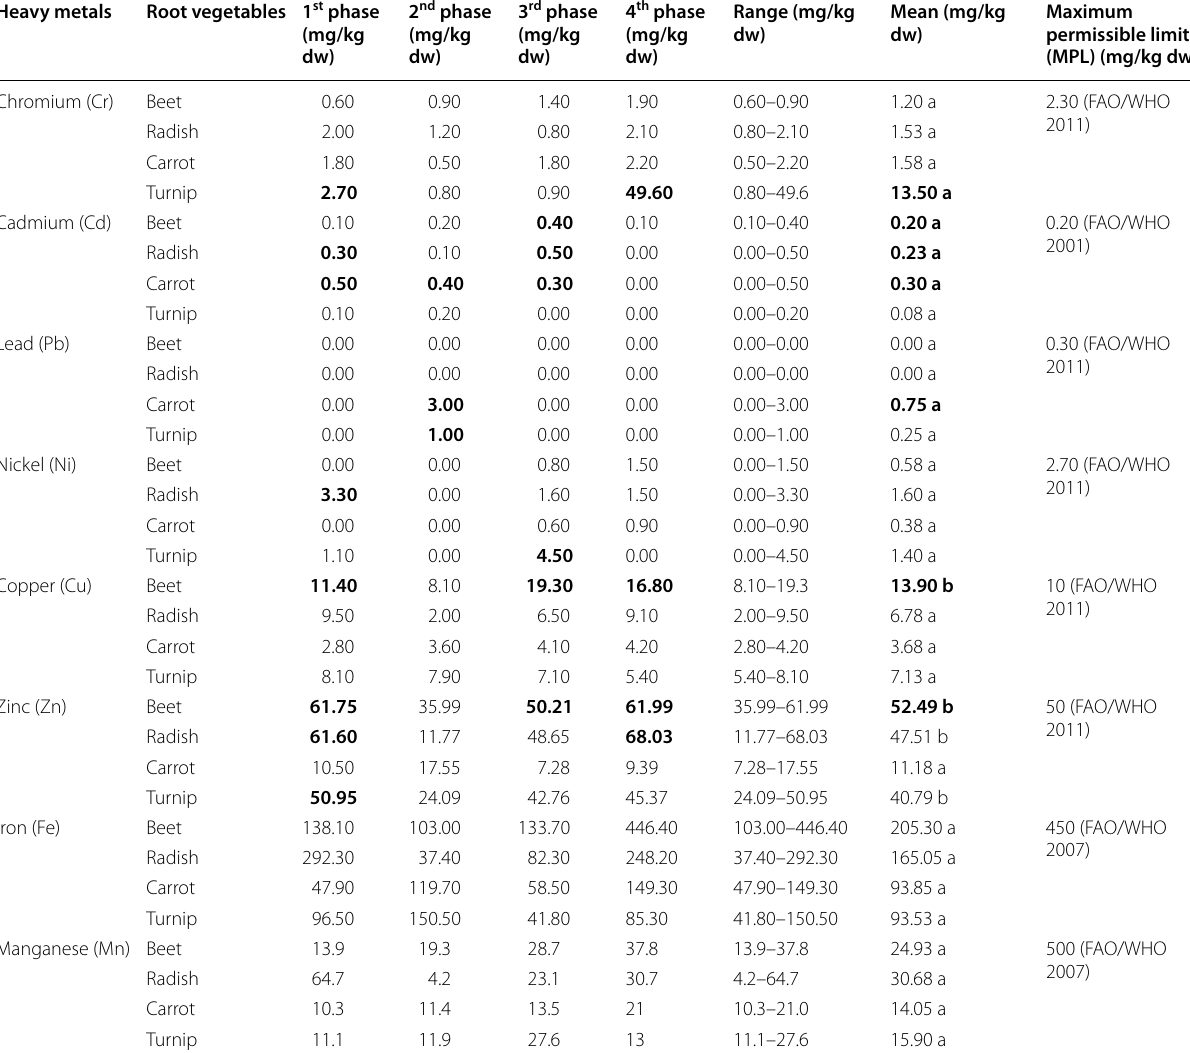
*DMRT analysis has been performed separately for each heavy metal. Mean values with the same letter(s) in a column of an individual heavy metal state no significant difference from each other at a 5% level by DMRT. The values in bold exceeded the maximum permissible limit set by the FAO/WHO